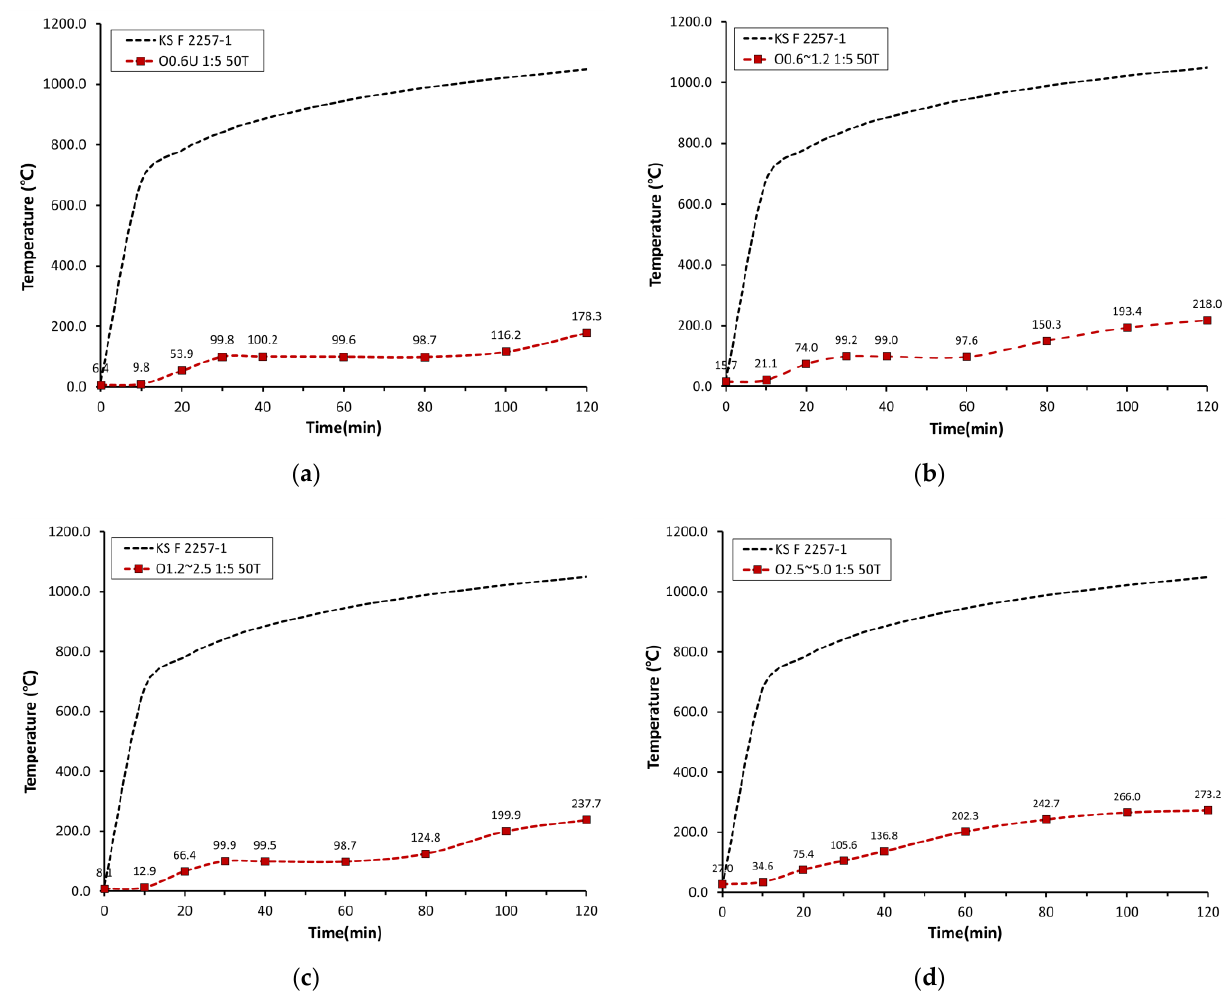
Figure 11. Back-side temperature results: ( a ) O0.6U M (mass ratio 1:5, 50T); ( b ) O0.6~1.2 M (mass ratio 1:5, 50T); ( c ) O1.2~2.5 M (mass ratio 1:5, 50T); ( d ) O2.5~5.0 M (mass ratio 1:5, 50T).